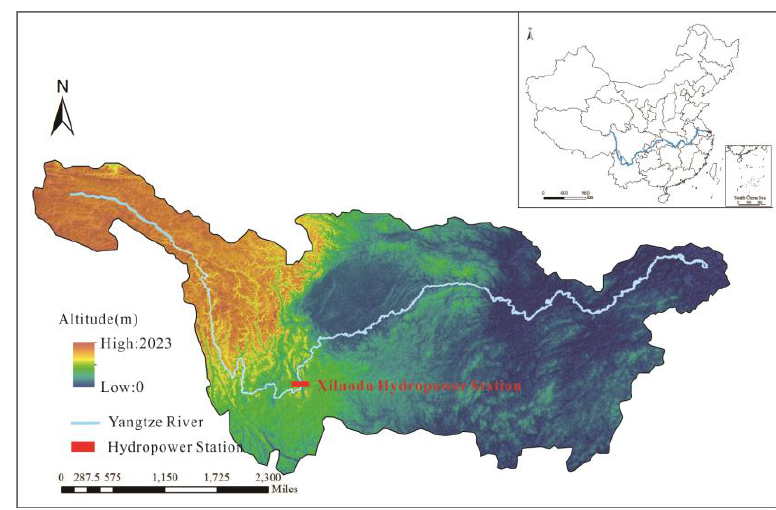
Figure 1. The location of Xiluodu (XLD) Reservoir.